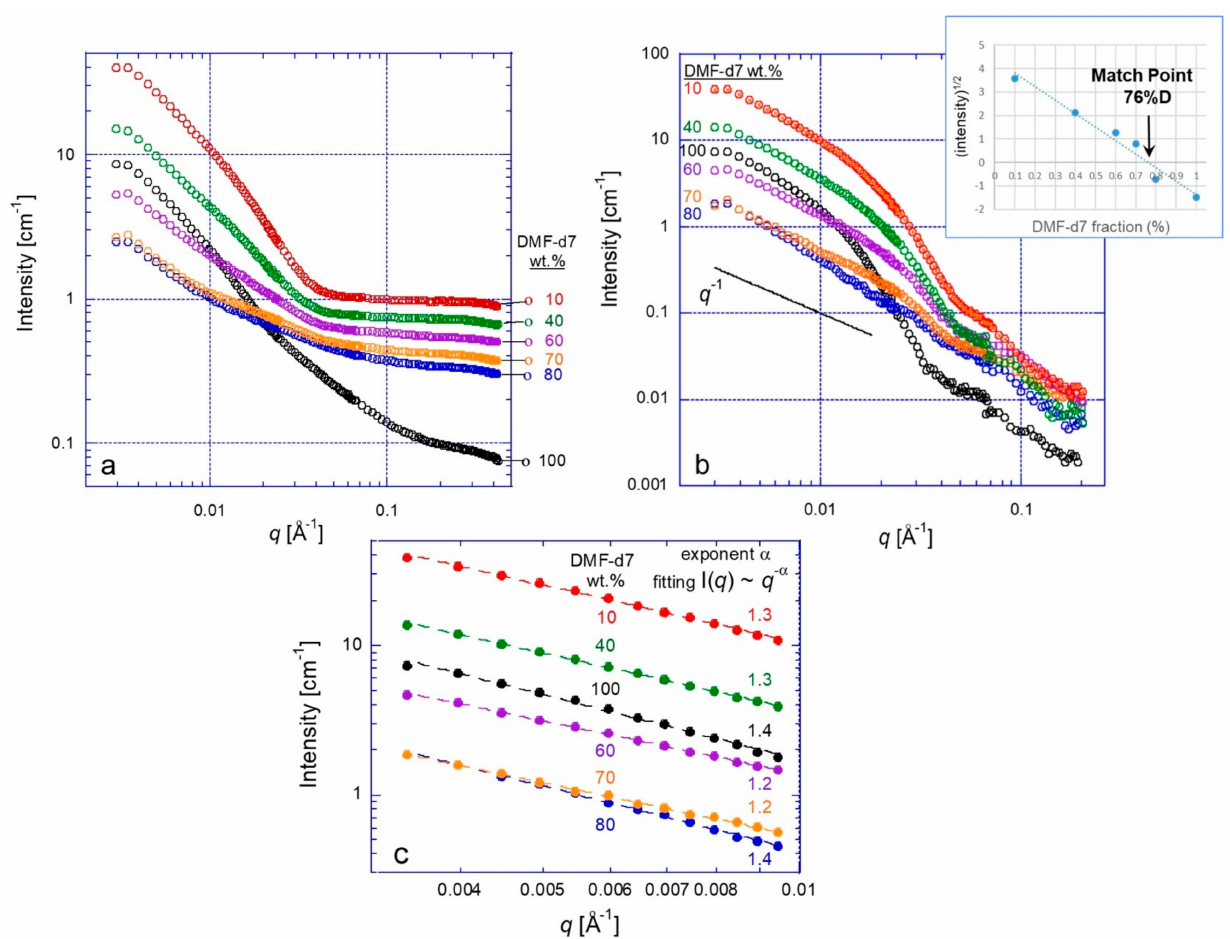
Figure 5. SANS patterns of 0.5 wt.% MWCNT + 1 wt.% S 12 -4VP dispersions, at six different contrasts: 100, 80, 70, 60, 40, and 10% DMF-d7, before ( a ) and after ( b ) background subtraction. Insert in ( b ) shows the matching point plot calculated at q = 0.0084 Å − 1 . Power law curve fits of the data at the low q range in ( b ) are plotted in ( c ) (double-log